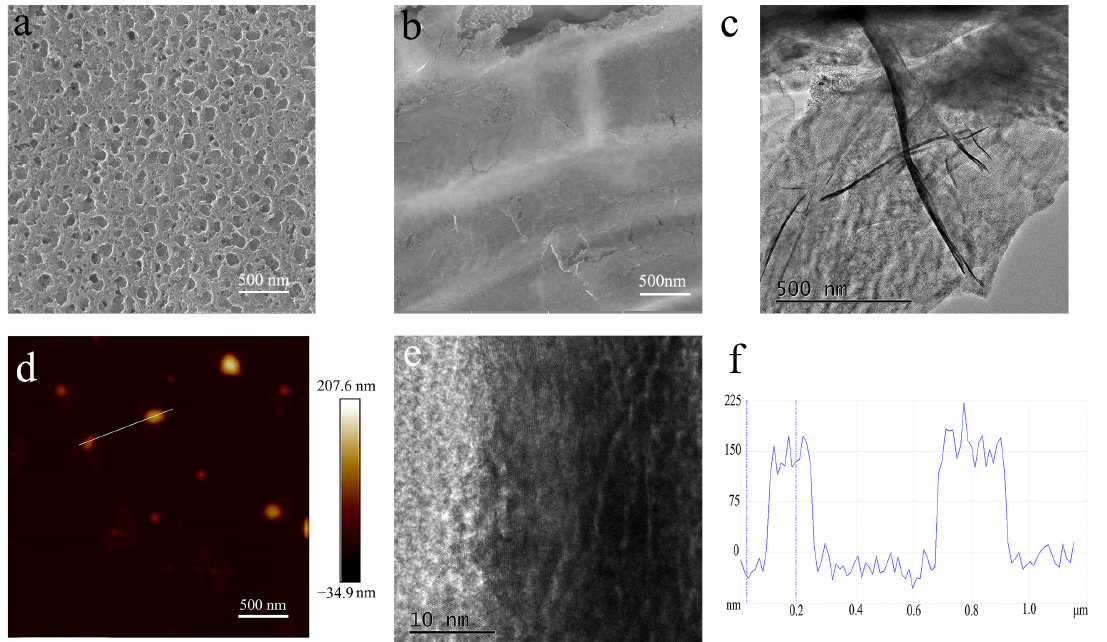
Figure 3. ( a , b ) SEM images of pore-rich PNCFs before and after PECVD ; ( c , d ) TEM images of the graphene shell in the pore-rich PNCFs@graphene; ( e ) AFM image of the graphene shell; ( f ) cross- section analysis is based on the chosen line.